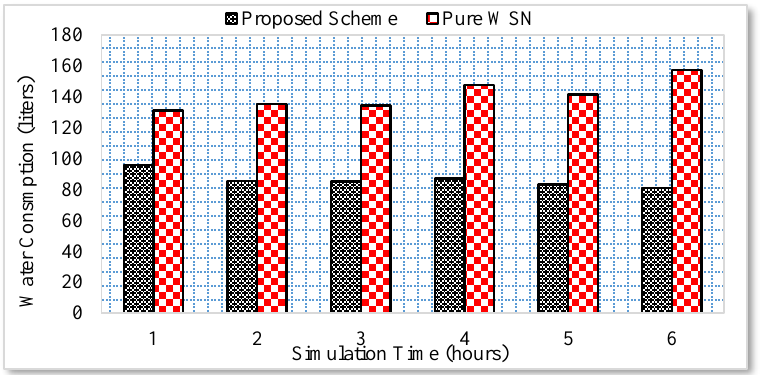
Figure 9. Water consumption analysis.